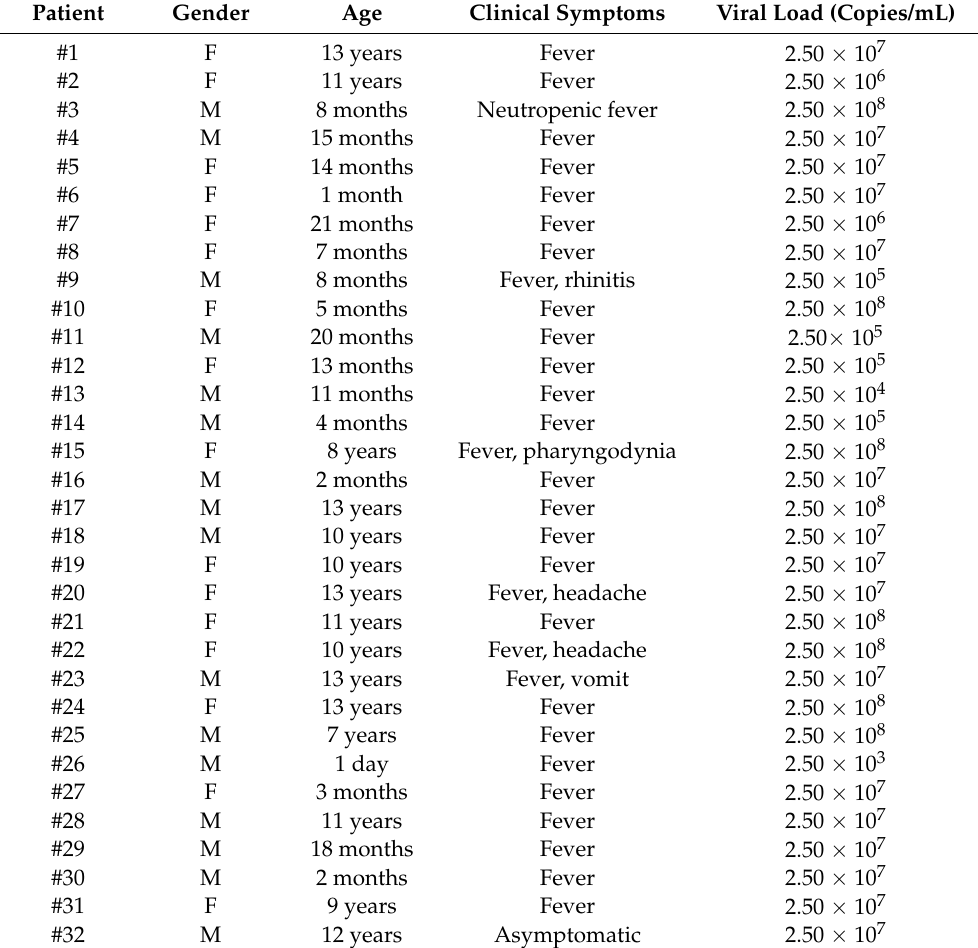
Table 2. Demographic and clinical data of SARS-CoV-2-positive study